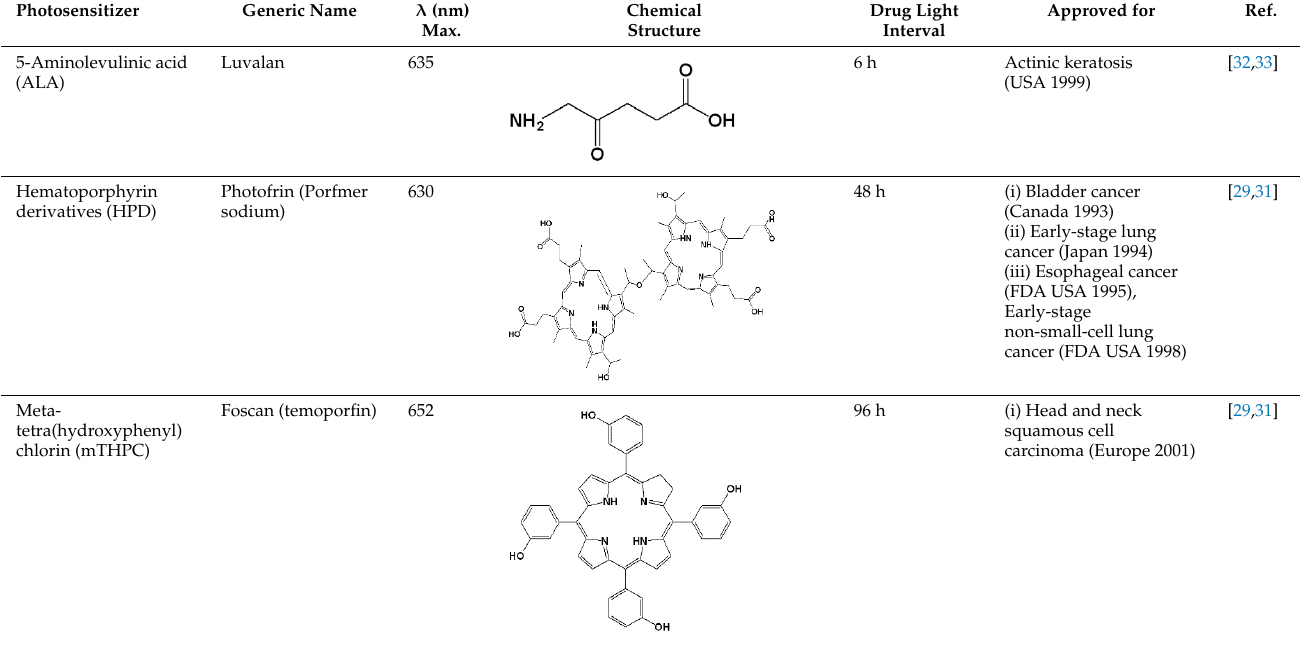
Table 1. Conventionally approved PS employed in PDT for cancer treatment.